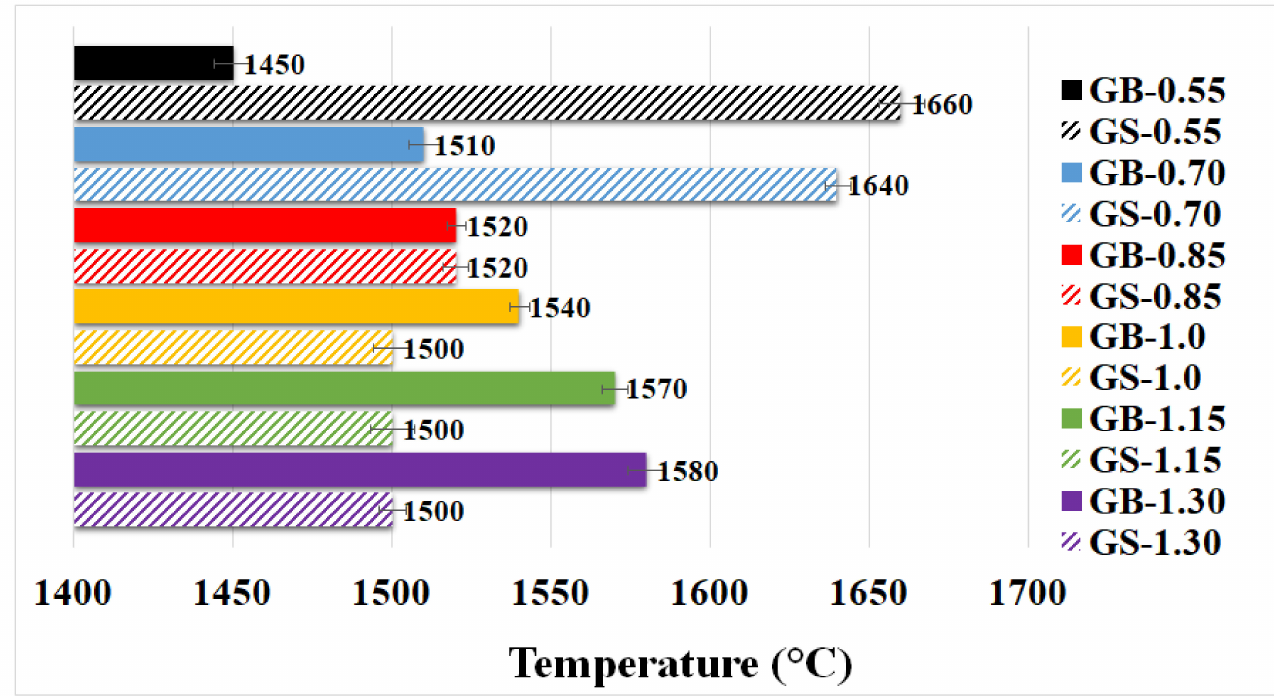
Figure 5. Pyrometric cone refractoriness of geopolymer binders (GB) and composites (GS) with various molar ratios of